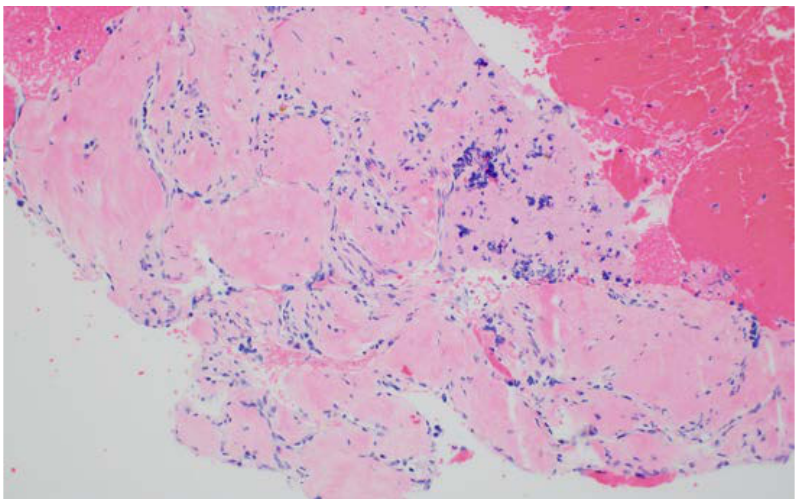
Figure 3. Serous cystadenoma cytopathology (courtesy of Dr. Michael G. Ozawa, Stanford University). Serous cystadenoma cytopathology showing cystic spaces separated by fibrous septa coalesced into a central scar. Hematoxylin and eosin stain, 100 × magnification